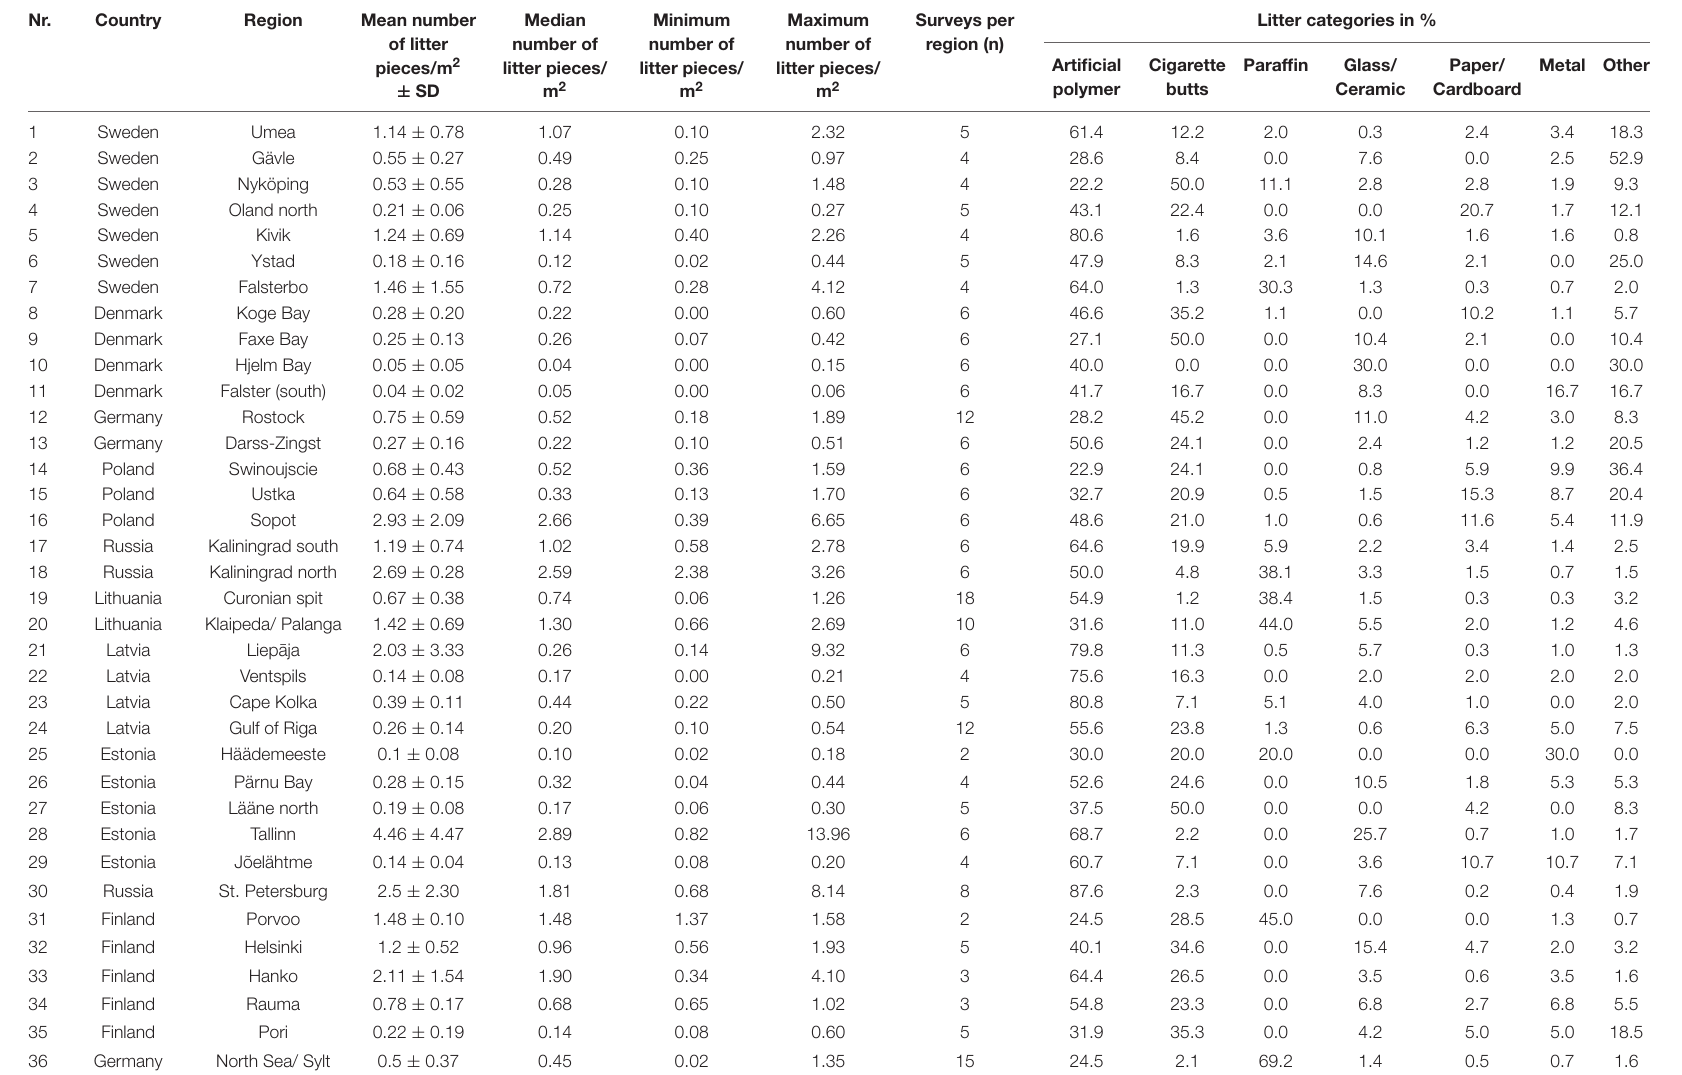
TABLE 1 | The average beach litter density for the 36 different regions in mean numbers of litter pieces/m 2 ± SD.